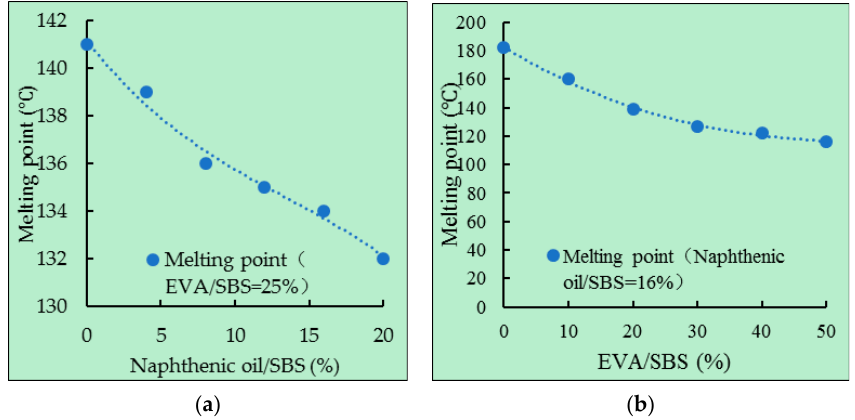
Figure 9. Melting points of different direct-to-plant SBS modifier: ( a ) EVA/SBS = 25% and ( b ) naphthenic oil/SBS = 16%.